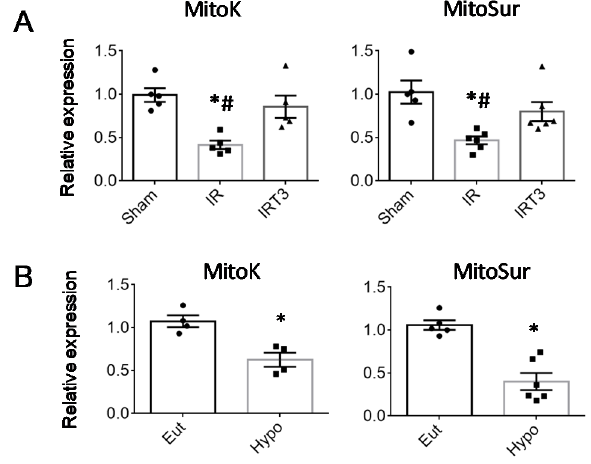
Figure 1. T3 restores mitoK and mitoSur expression levels in the rat heart. The relative expression of mitoK and mitoSur was measured ( A ) in the LV area at risk at 3 d from the IR procedure followed by treatment with T3 at physiological doses (3 µ g per kg per day) for 48 h (IRT3). n = 5 animals per group, * p = 0.002 vs. Sham; # p ≤ 0.02 vs. IRT3; and ( B ) in LV from euthyroid (Eut) and hypothyroid (Hypo) rats. n = 4 animals per group, * p < 0.0001 vs. Eut.